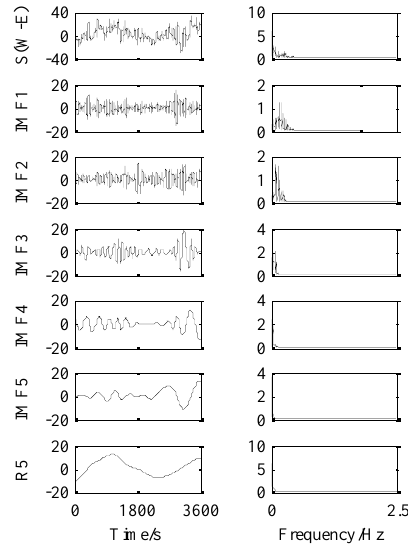
Figure 12. Decomposition result of the denoised signal in the horizontal direction using EMD.